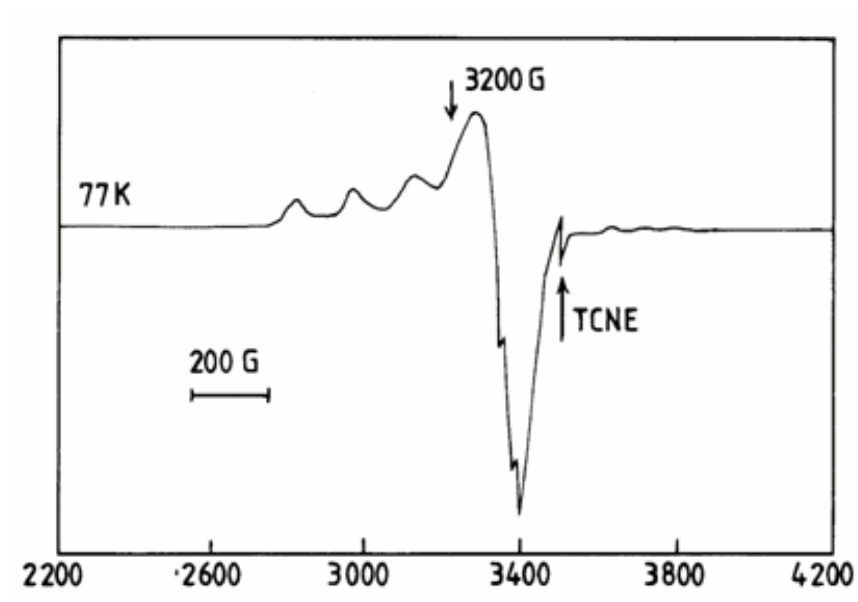
Fig. 2 ESR spectra of copper complex at 77